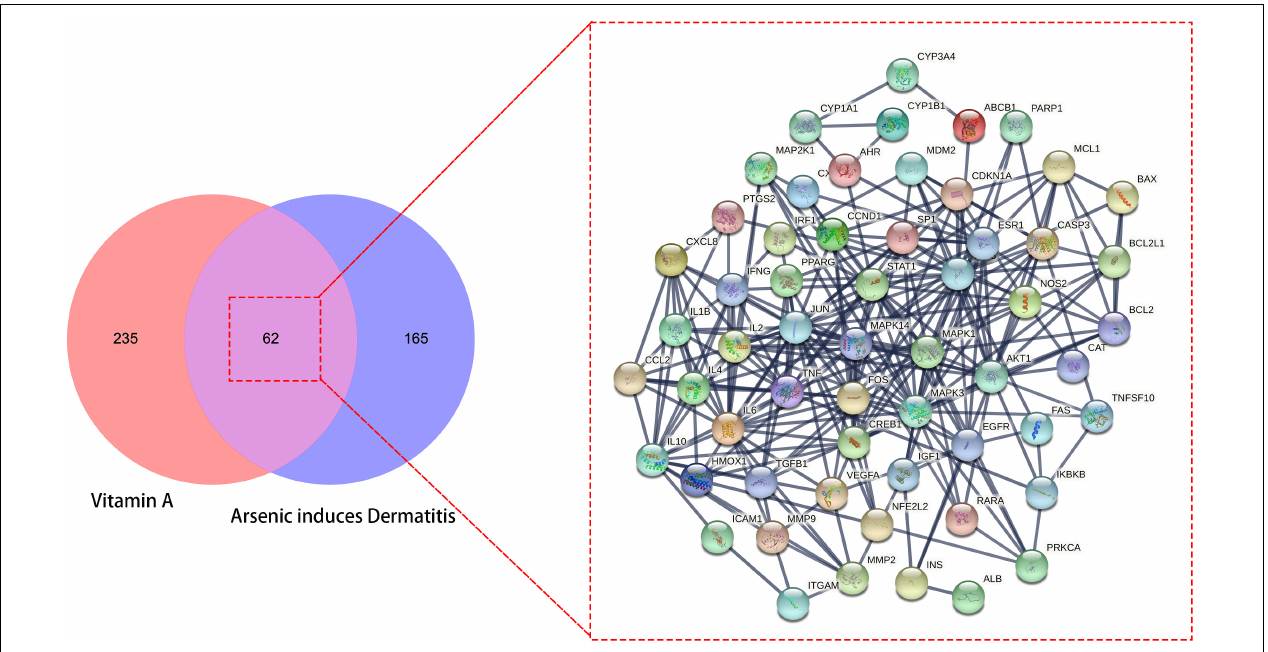
FIGURE 1 | All candidates, mutual target genes in vitamin A (VA) drug repurposing for As-linked dermatitis in Venn diagram, as characterized in an interlaced network.